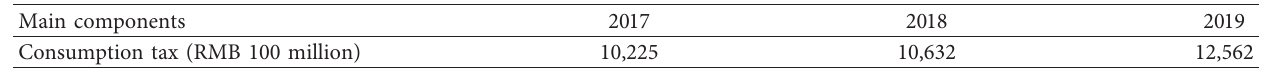
Table 2: Domestic consumption tax income (2017–2019).